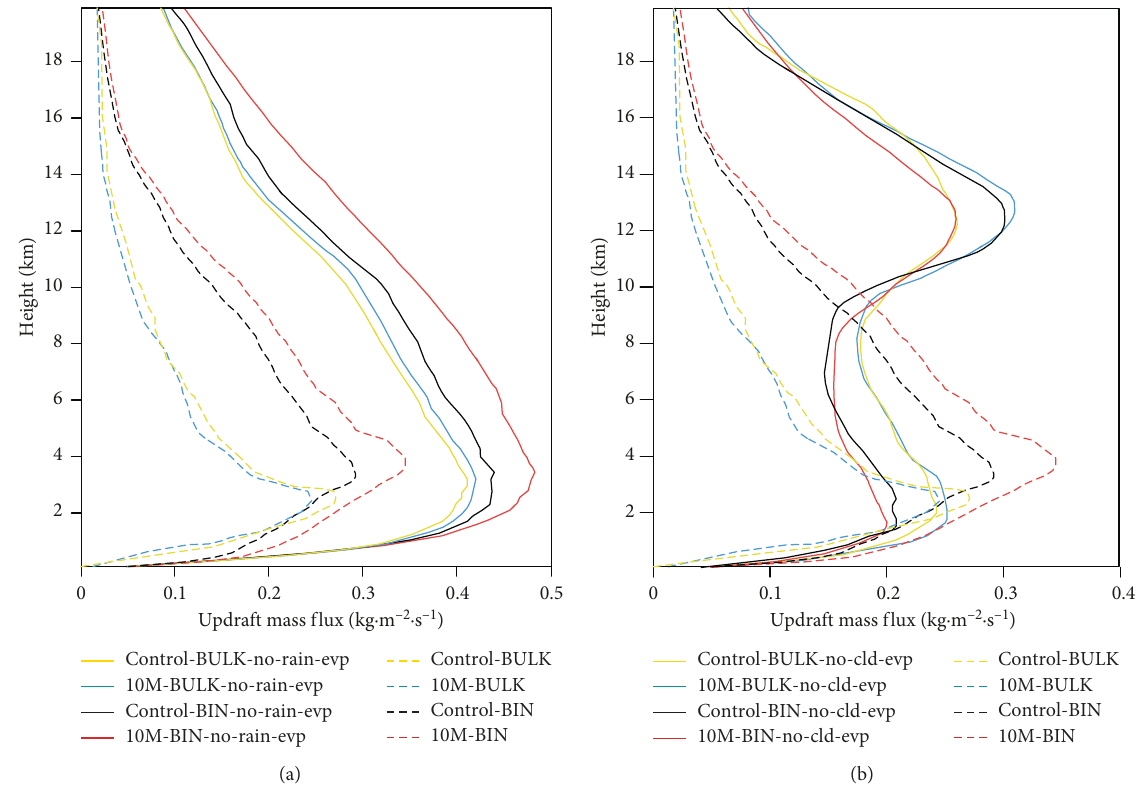
Figure 7: (a) Vertical distributions of the time- and domain-averaged updraft mass fluxes for the standard runs, the control-BIN-no-rain- evp run, the 10M-BIN-no-rain-evp run, the control-BULK-no-rain-evp run, and the 10M-BULK-no-rain-evp run. (b) Vertical distributions of the time- and domain-averaged updraft mass fluxes for the standard runs, the control-BIN-no-cld-evp run, the 10M-BIN-no-cld-evp run, the control-BULK-no-cld-evp run, and the 10M-BULK-no-cld-evp